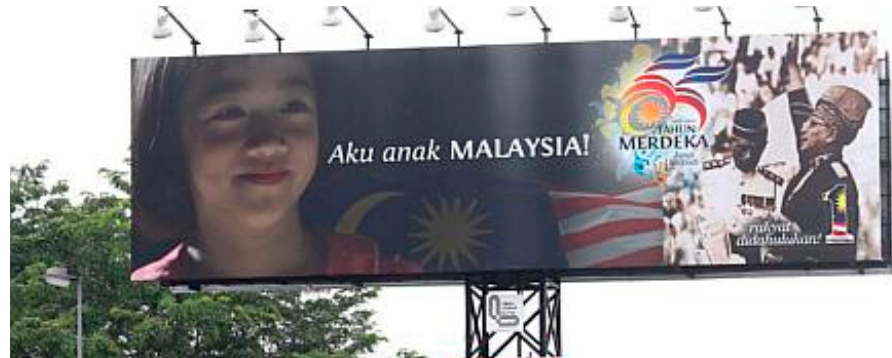
Figure 2. Aku anak Malaysia billboard.